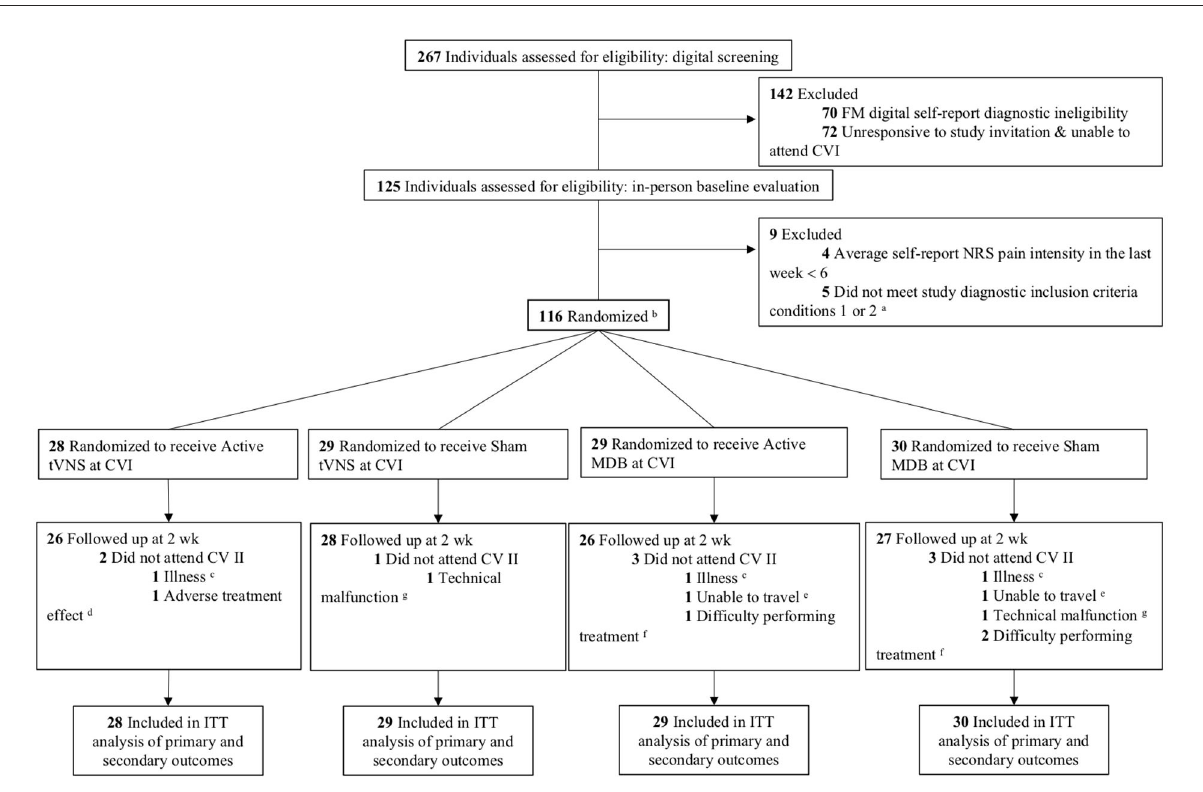
FIGURE1 CONSORT flow diagram of study participation. a Condition 1: Widespread pain index (WPI) ≥ 7 and symptom severity scale (SSS) score ≥ 5; Condition 2: WPI of 4–6 and SSS score ≥ 9. b Of the 116 participants randomized, 86 completed 80% of their assigned home treatment (i.e.,